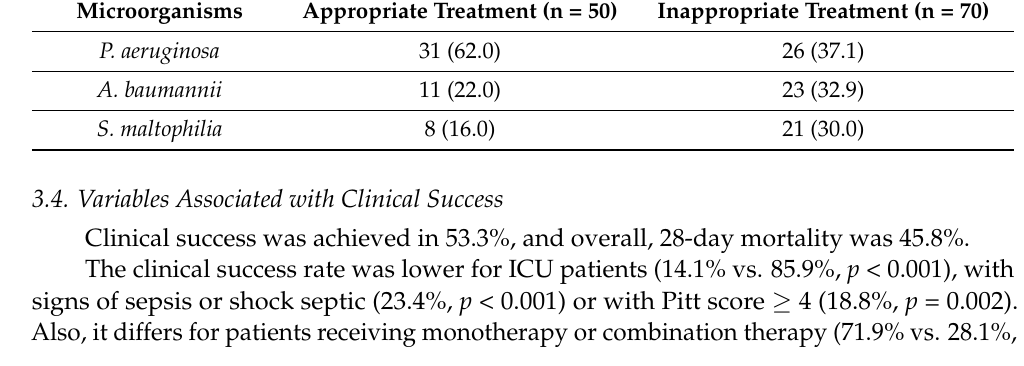
Table 3. Appropriateness of the treatment according to the isolated microorganism. Microorganisms Appropriate Treatment (n =